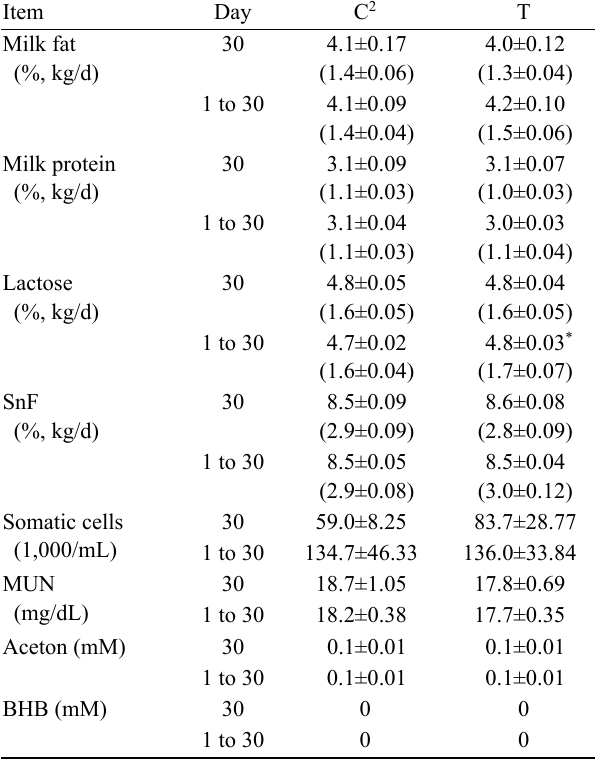
Table 5. Effect of dietary phytoncide on milk fatty acid contents in dairy cows